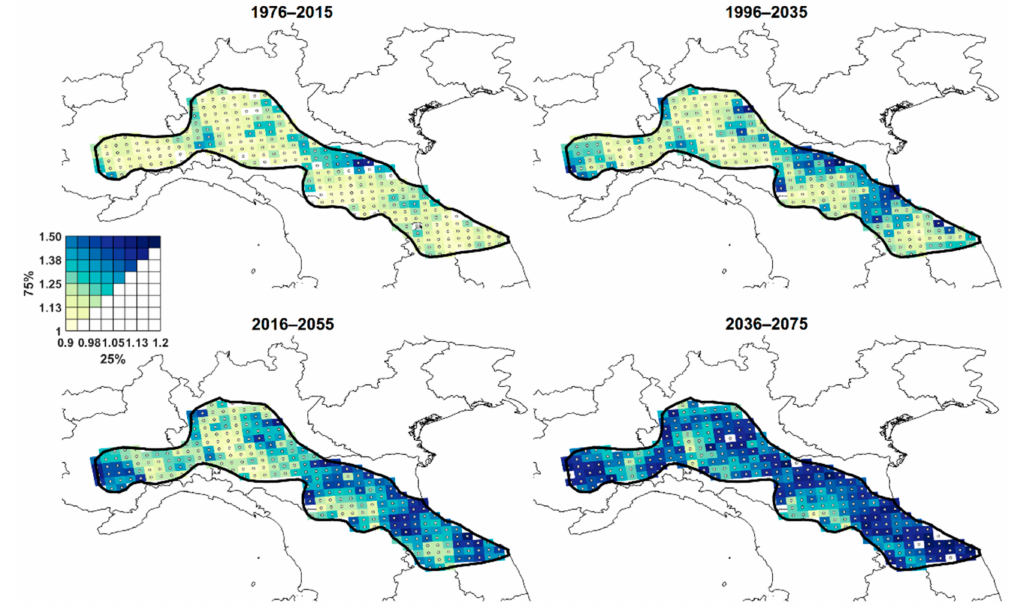
Figure 11. Factors of change for p r,k in the time windows 1976–2015, 1996–2035, 2016–2055, and 2036–2075 in comparison with the reference time interval 1956–1995—prediction interval (25–75%) map (Scenario